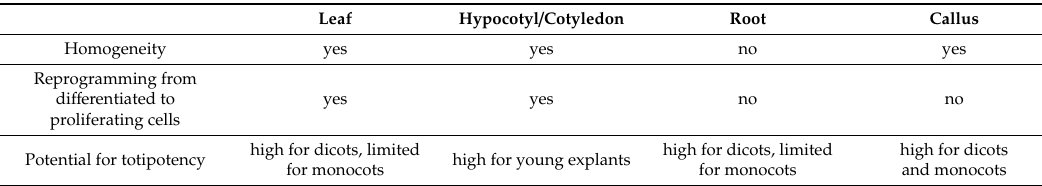
Table 1. Comparison of di ff erent angiosperm protoplast sources to study cell reprogramming (summarised from